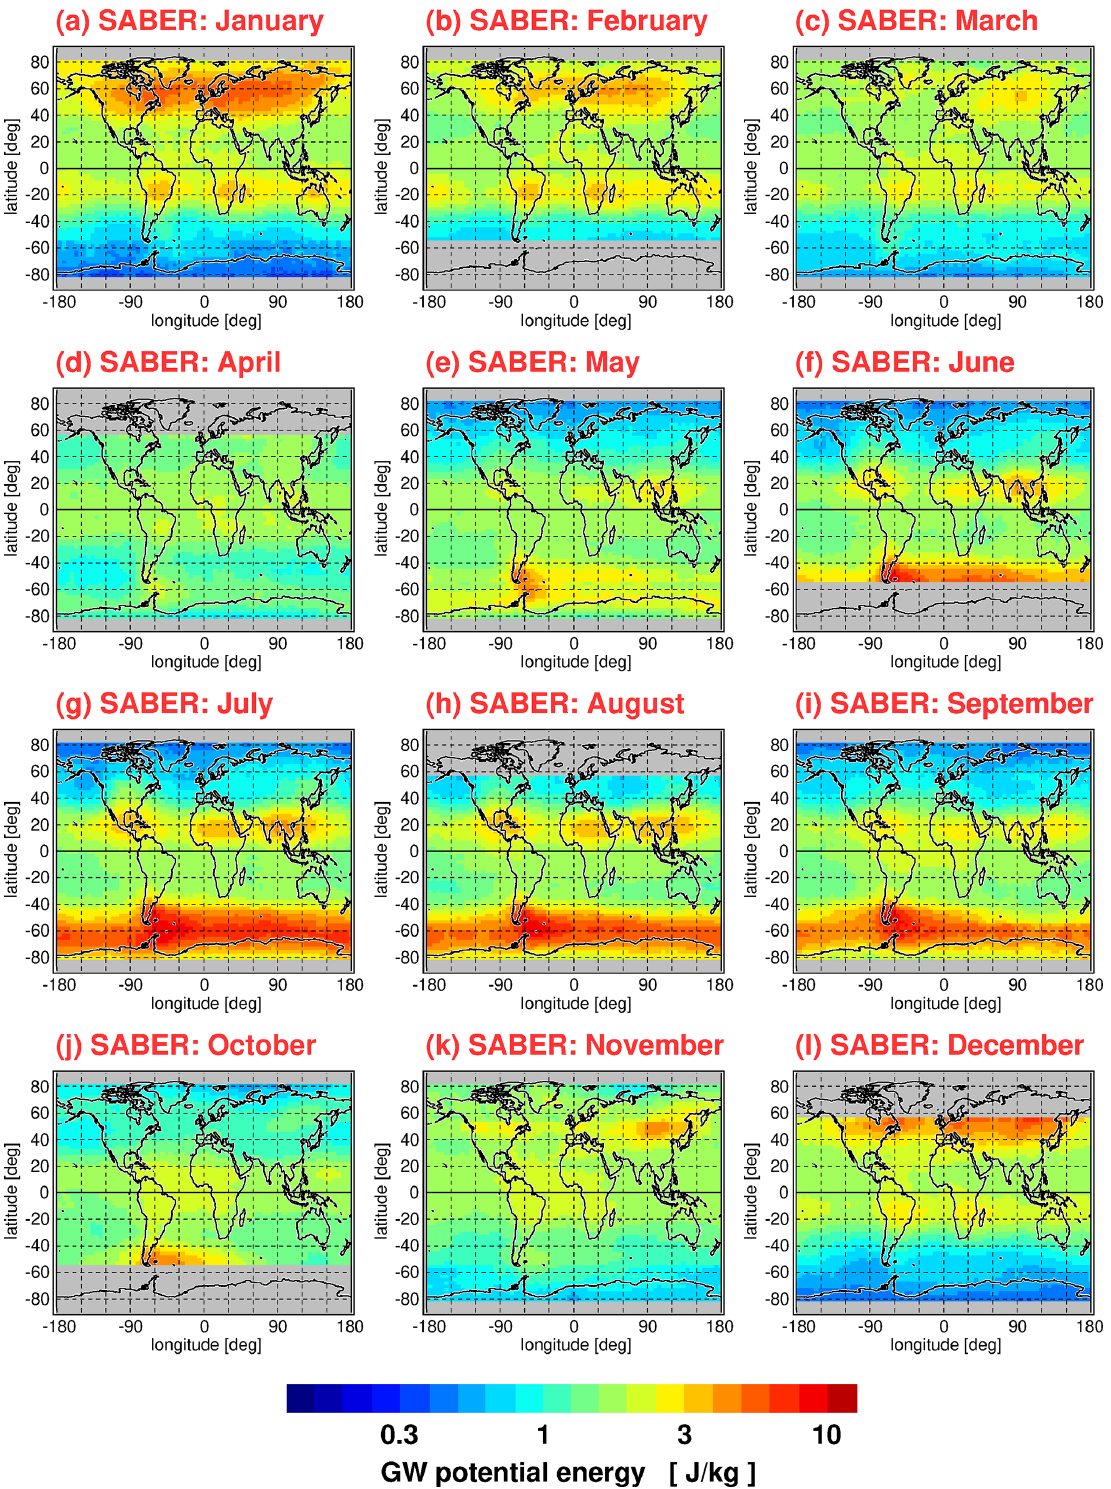
Figure 2. Global distributions of SABER gravity wave (GW) potential energies at 30km altitude for each calendar month. Values shown are multiyear means of monthly median values determined in overlapping 10 ◦ × 15 ◦ (latitude × longitude) grid boxes. The period used for averaging is January 2002 to October